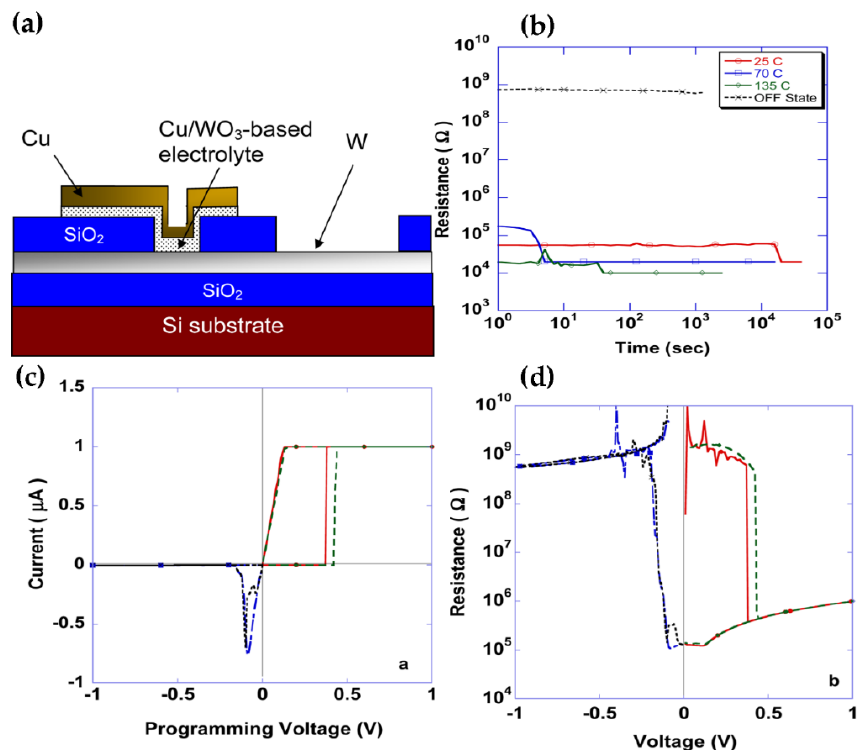
Figure 18. Diagram of cross-section and electrical behavior of Cu-doped WO 3 devices. ( a ) Diagram of a cross-section of device. The region of the active device is the W-electrolyte-Cu layer superimposed together, and its area is defined by the diameter of the through-hole in the SiO 2 dielectric. ( b ) Data retention behavior of Cu-doped WO 3 devices at 10 µ A and 1 V. ( c ) I-V diagram of the device at 1 µ A. ( d ) R-V plot of the device. Reproduced or adapted from [90].